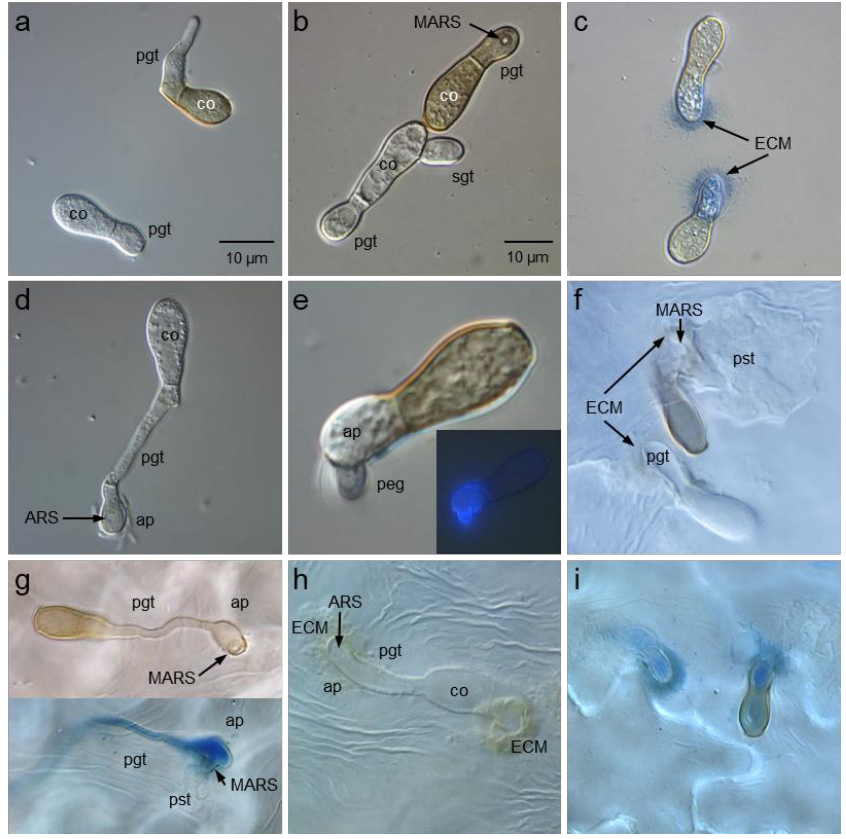
Figure 3. Germination of conidia of the Venturia inaequalis isolates HS1 (wild-type) and SW01 (melanin-deficient-mutant) on glass surfaces ( a to e ) and penetration of apple leaf surfaces after formation of appressoria ( f to i ). Melanised conidia (co) most often produced only a short primary germtube (pgt; a, b ) and an appressorium with a melanised appressorial ring structure (MARS, b ), whereas SW01 conidia often produced a second germtube (sgt; b ). The formation of appressoria (ap) was associated with the release of an extracellular matrix (ECM) surrounding the appressoria of both isolates ( c , f , h ); The appressorial ring structure (ARS) of SW01 appressoria remained non-melanised ( d ); the wild-type isolate sometimes formed a penetration peg even on a glass surface; fluorescence images of aniline blue-stained samples (insert) confirmed the absence of melanin from the appressorium body and the peg ( e ), whereas the appressorial ring structure at the interface of appressorium and leaf cuticle was melanised and resulted in a primary stroma (ps) beneath the plant cuticle for the wild-type isolate HS1 ( g ); ECM around appressoria produced by isolate SW01 were often larger than ECM around HS1 appressoria ( h , i ).